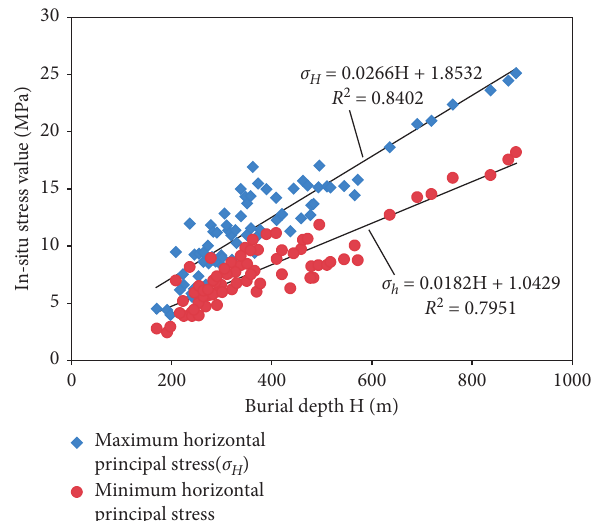
Figure 4: Relationship between the horizontal principal stress and burial depth H.